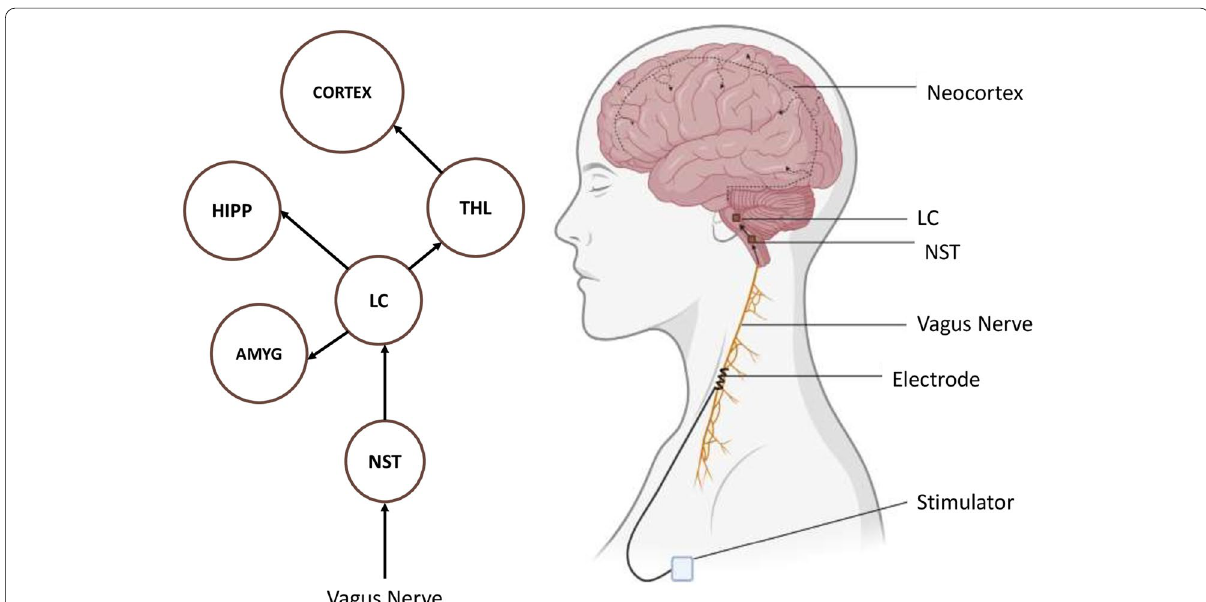
Fig. 3 Illustration of electrode placement in the neck accompanied with implanted stimulator, and the efferent vagus nerve pathway . The nucleus of the solitary tract (NTS) receives information from afferent fibers in the vagus and sends excitatory fibers, mostly glutamatergic, to the locus coeruleus (LC). This in turn sends noradrenergic projections to the amygdala (AMYG), thalamus (THL) and hippocampus (HIPP), and finally the cortex receives thalamic inputs. Created with